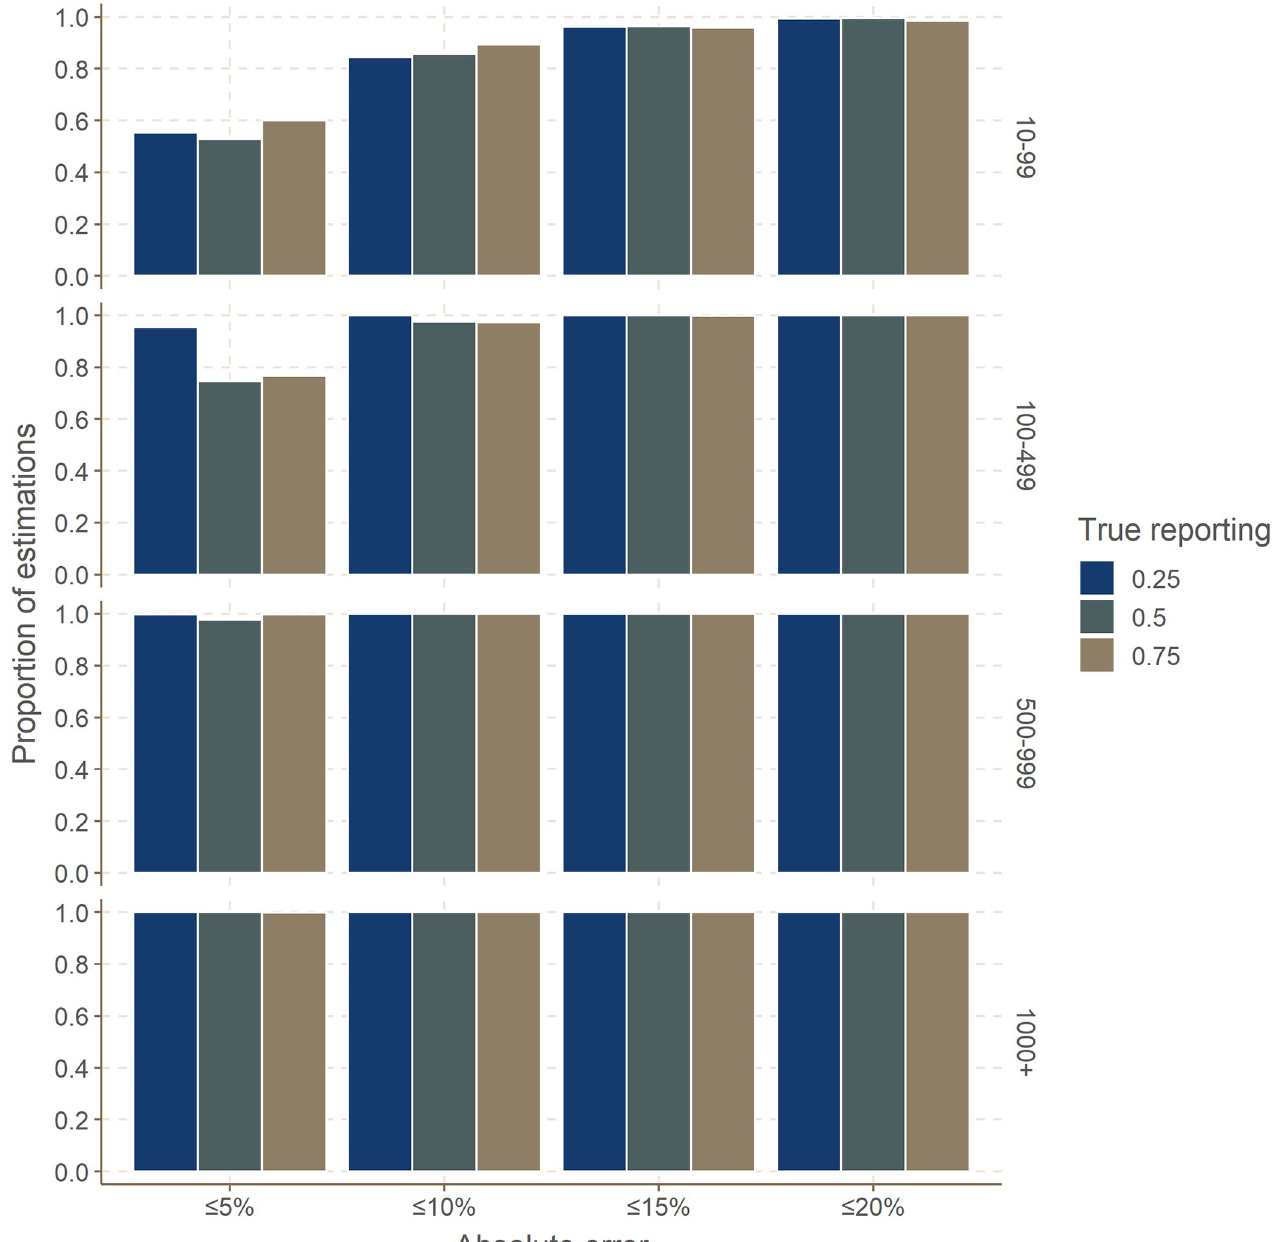
Fig 4. Absolute error in reporting estimation. This graph shows, for different simulation settings, the proportion of results within a given margin of absolute error, expressed as the absolute difference between the true and the estimated reporting (in %). Rows correspond to different outbreak size categories (outbreak size as reported). True reporting is indicated in